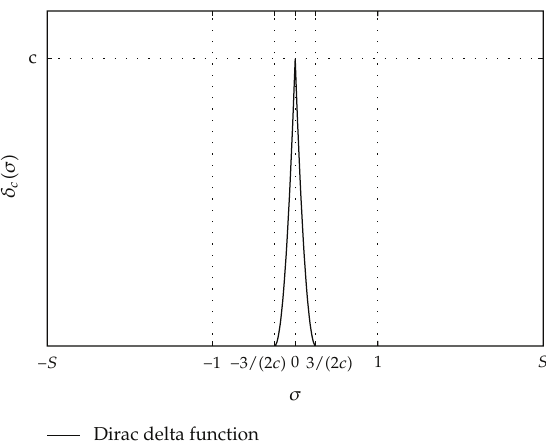
Figure 2: Approximation of Dirac delta